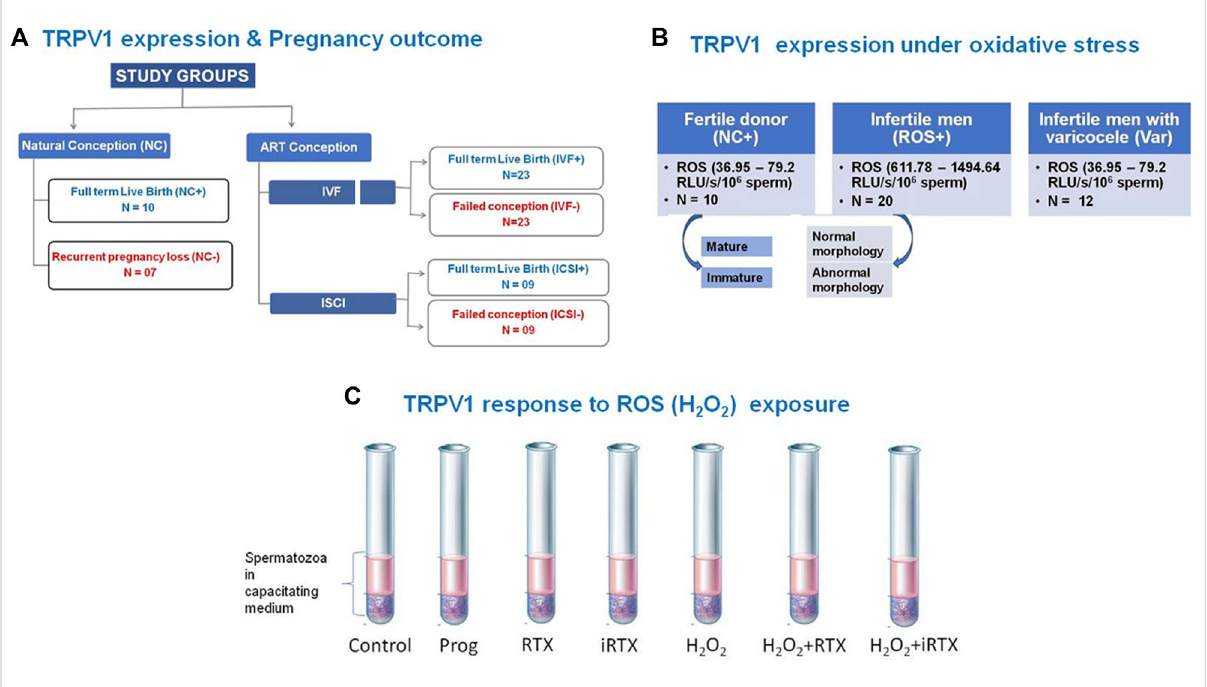
Schematic representation of experimental design including patient selection. (A) Expression of TRPV1 in spermatozoa as a function of pregnancy outcome by natural conception and assisted reproductive technology (ART); (B) expression of TRPV1 in spermatozoa as a function of altered redox status; (C) validation of regulation of TRPV1 function in human spermatozoa by ROS in vitro . IVF, in vitro fertilization; ICSI, intracytoplasmic sperm injection; ROS, reactive oxygen species; Prog, progesterone, RTX, resinferatoxin; iRTX, 5iodoresinferatoxin; RLU, relative light